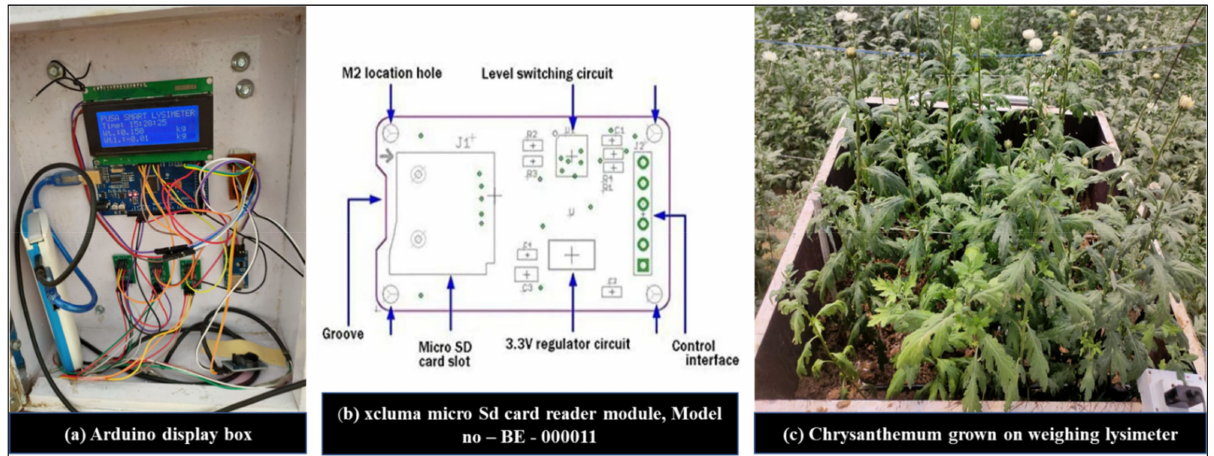
Figure 10. ( a ) Arduino display box, ( b ) Sd card reader module, and ( c ) Chrysanthemum grown on a